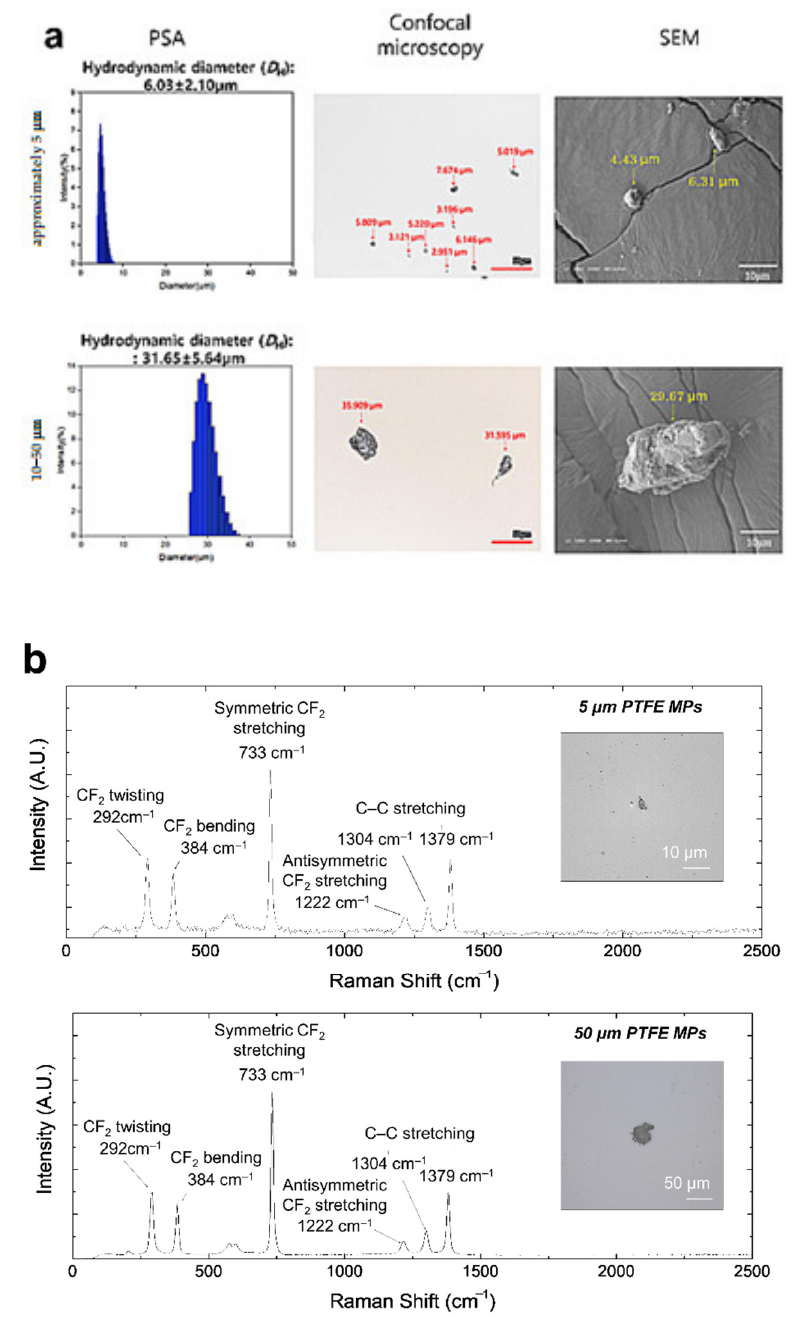
Figure 1. Characterization of PTFE microplastics. ( a ) Analysis with PSA, confocal microscopy, and scanning electron microscopy, ( b ) Raman spectra of approximately 5 μm and 10‒50 μm-sized PTFE microplastics captured on silicon filters. Inset images show representative PTFE microplastics. Scale bar = 10 μm and 50 μm.